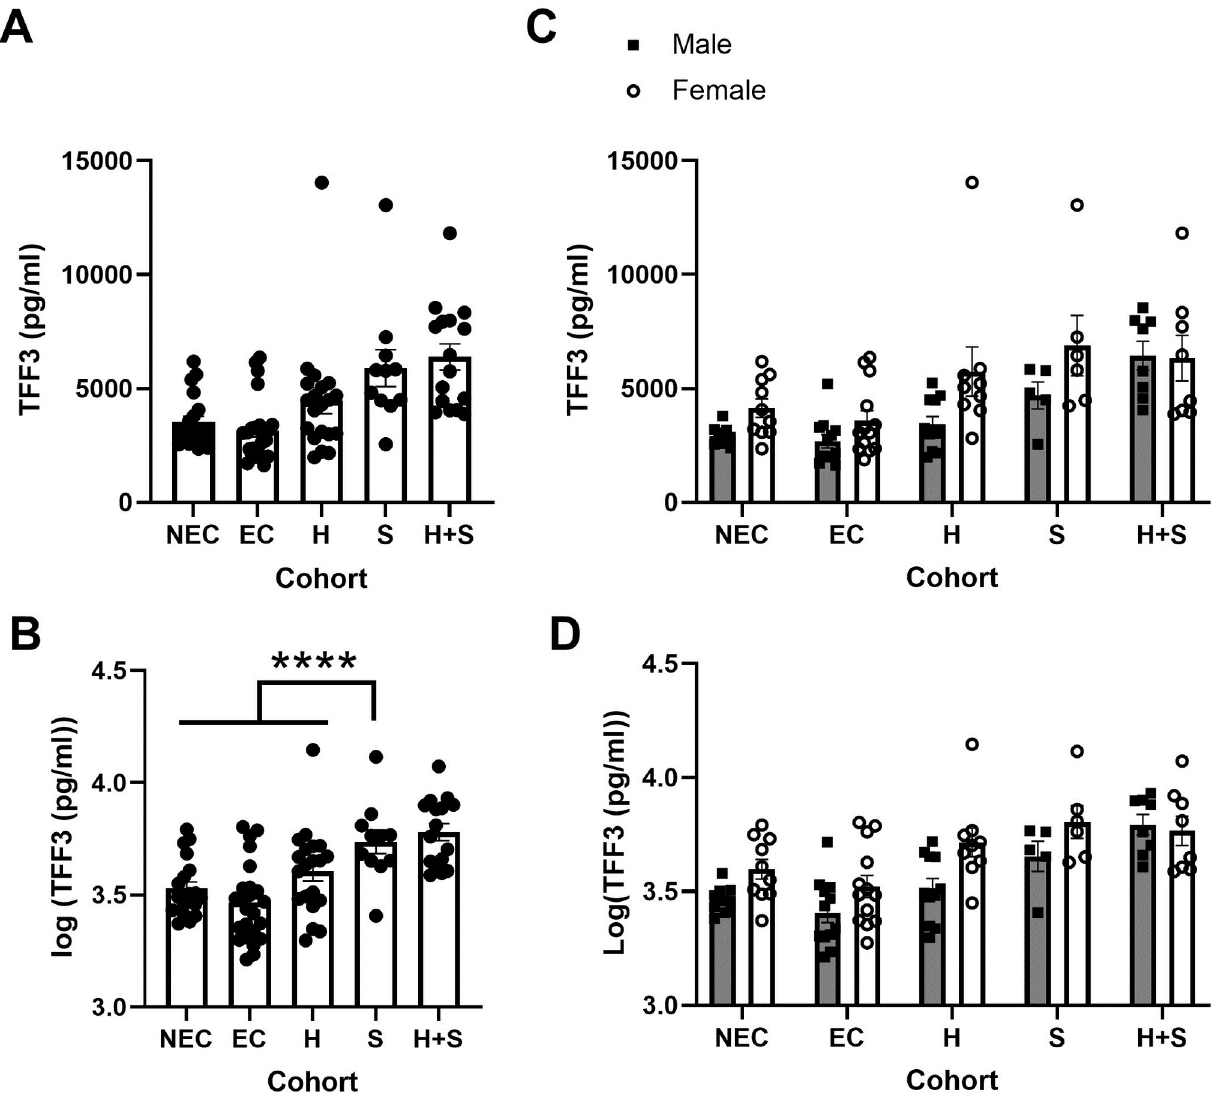
Fig 2. TFF3 serum levels are higher in Schistosoma infection than Hookworm or control in individuals from Brazil. (A,B) Levels of TFF3 and log transformed data in cohorts with sexes pooled or (C,D) with sexes shown separately in serum samples from Brazilian patients with either Schistosoma (S, n = 11, 6 female), Hookworm (H, n = 20, 9 female), or both (H+S, n = 16, 8 female) versus uninfected controls (endemic, EC, n = 25, 13 female and non- endemic, NEC, n = 20, 10 female). ���� p < 0.0001 for three indicated groups vs Schistosoma